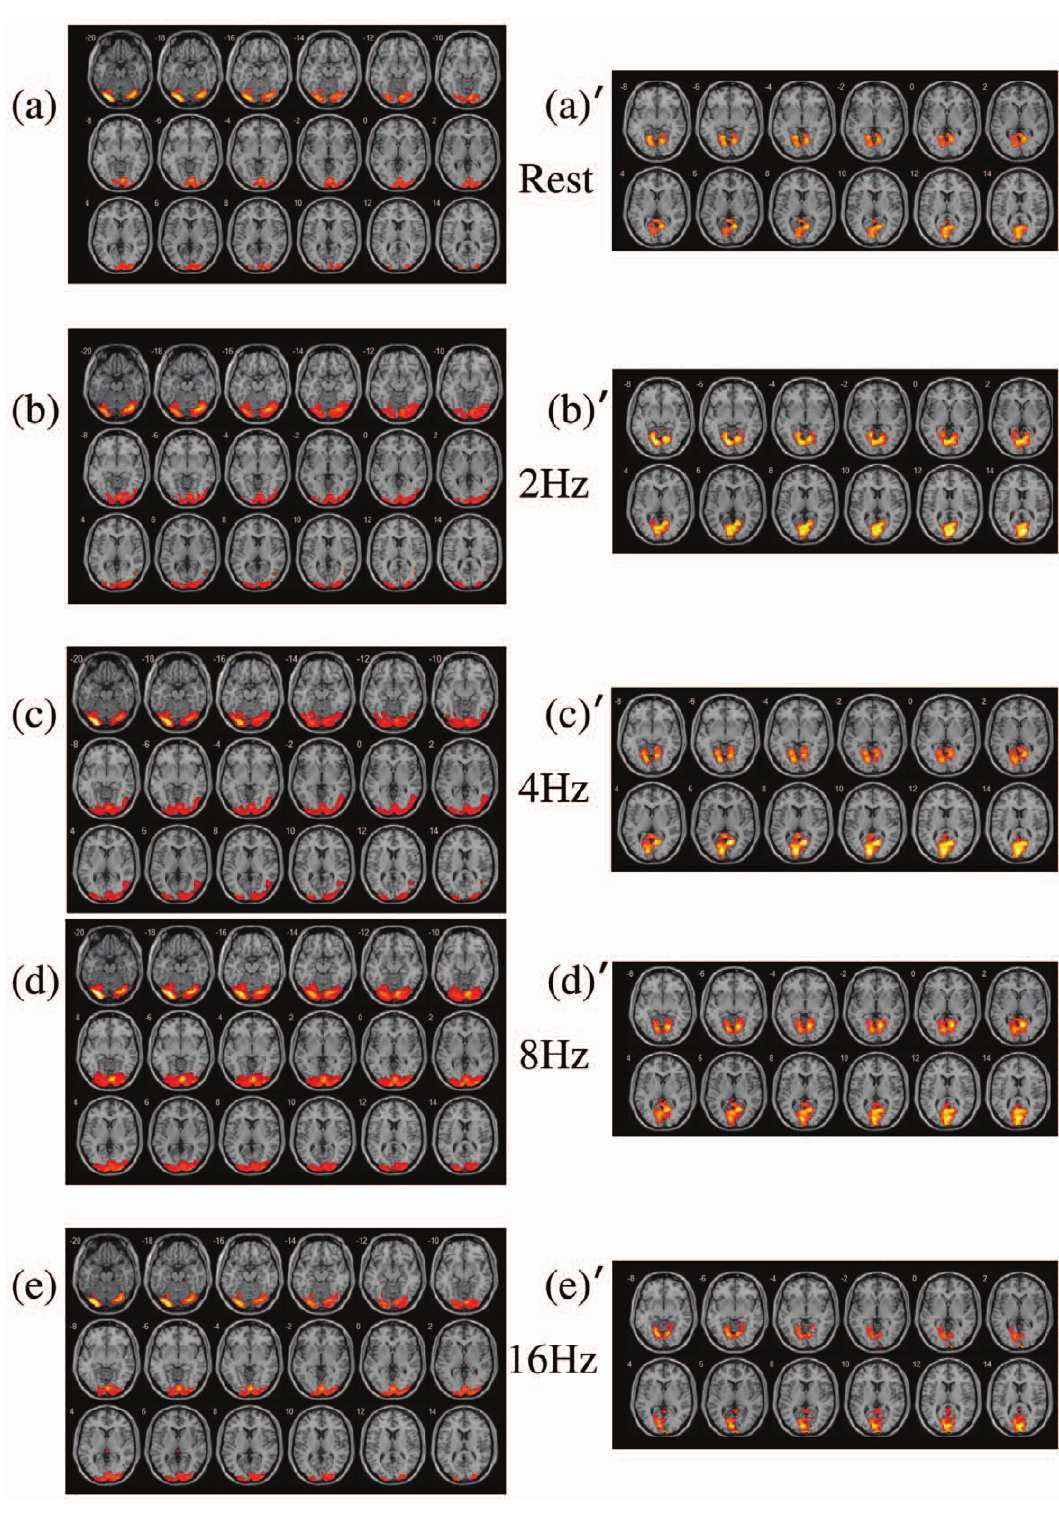
Figure 1. Impact of repetition rate on the patterns of two subsystems in visual network. (The number in left upper corner of each image represented the location of the image in z-direction of Talairach coordinates.) doi:10.1371/journal.pone.0018954.g001 between 0–16 Hz. The interregional functional connections were stimulation frequencies at around 20, 40, and 80 Hz [25–27]. found to peak at 8 Hz. In addition to around 8 Hz peak, previous These peaks might be due to neural oscillators, which preferably literatures demonstrated that other peaks were observed for oscillate at certain frequencies, so called ‘‘resonance frequencies’’.